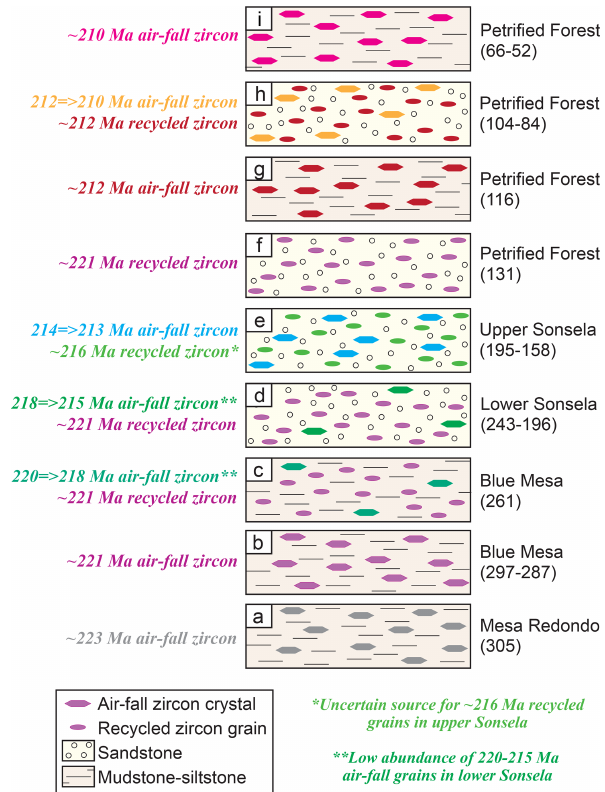
Figure 14. Depositional model of strata of the Chinle Formation encountered in the CPCP core. Each time slice contains informa- tion about the dominant grain size of the host sedimentary rock, the abundance of syn-depositional-age zircon grains that are interpreted to be of air-fall origin, and the abundance of recycled zircon grains that predate